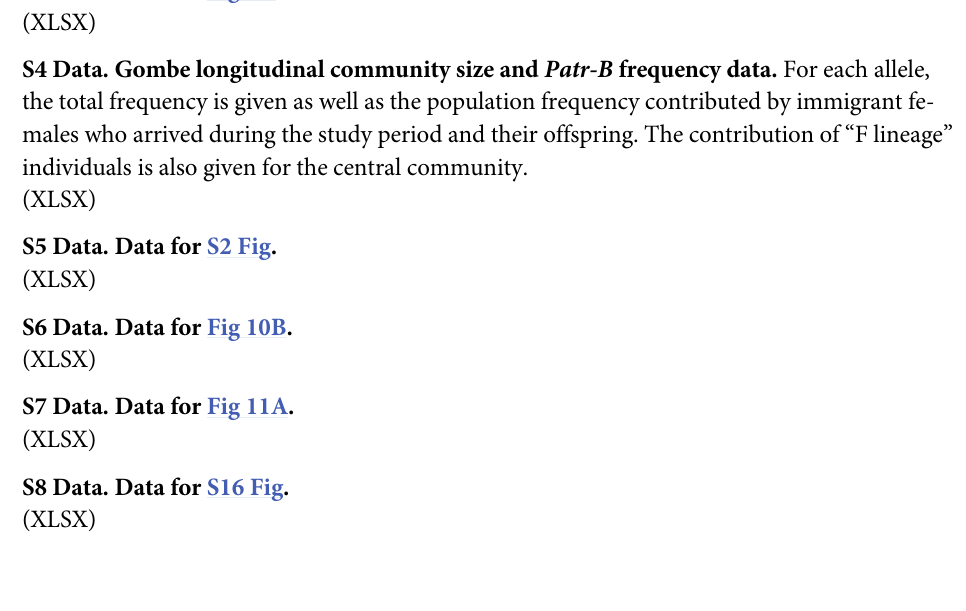
S1 Data. Data for Fig